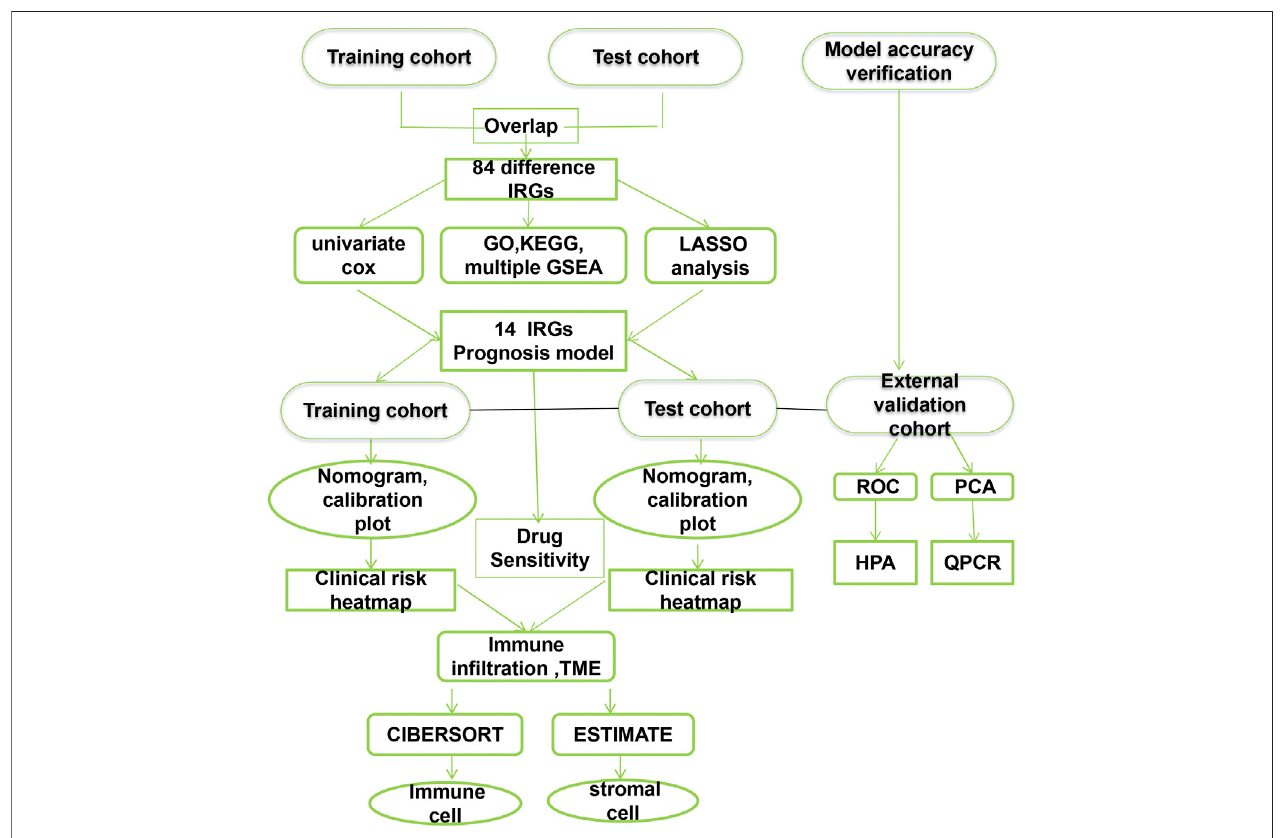
FIGURE 1 | The fl ow chart of the analytical